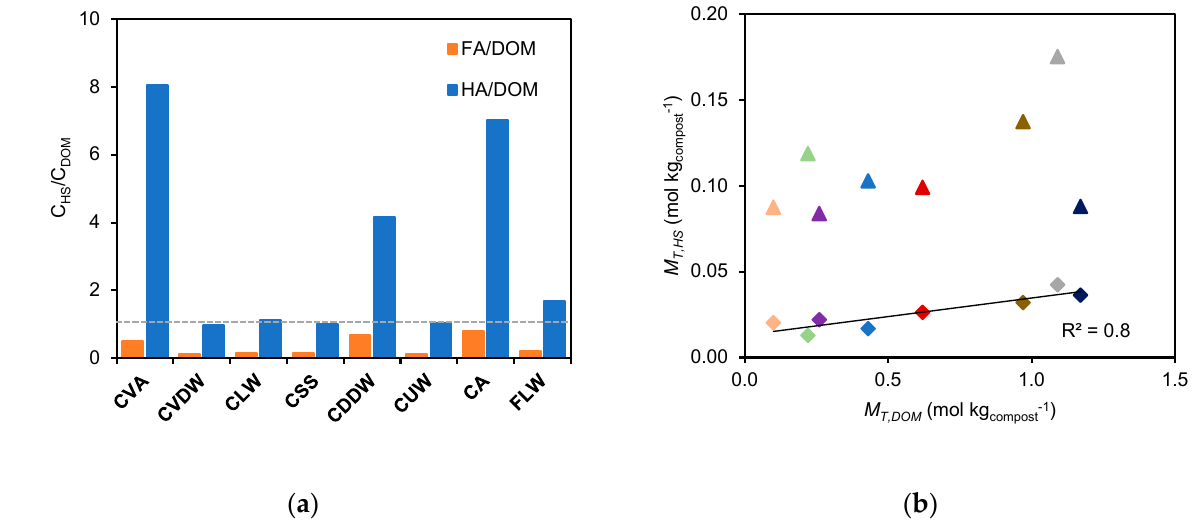
Figure 3. ( a ) Ratio between the carbon content in the humic extracts (FA and HA) with respect to the present in DOM ( C HS / C DOM ), the horizontal line is settled for C HS / C DOM = 1 and ( b ) correlation between the abundance of acid sites in FA ( ♦ ) and HA ( ∆ ) and the abundance of acid sites in DOM of the composts: CDDW (purple), CVDW (red), CVA (green), CA (coral), CUW (blue), CSS (dark blue), CLW (brown), and FLW (grey).